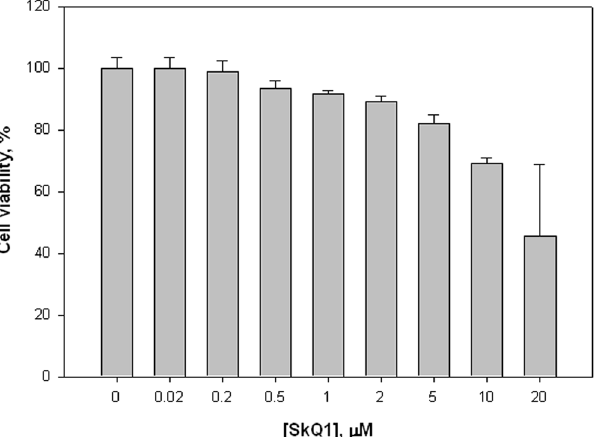
Figure 7. Viability of HeLa cells after the addition of SkQ1. HeLa cells were incubated for 17 h. Cell viability was determined with Cell Titer-Blue reagent (Promega).